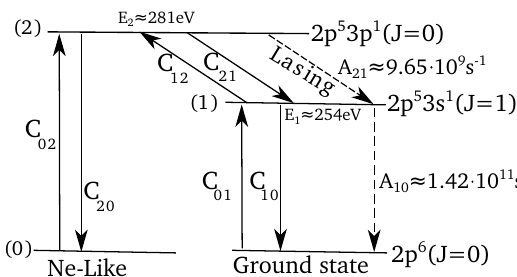
Figure 1. Grotrian scheme and the transitions for the lasing of the Ne-like Ar +8 . The energy levels schematically are composed of the upper (2) and lower (1) lasing levels and the ground (0)